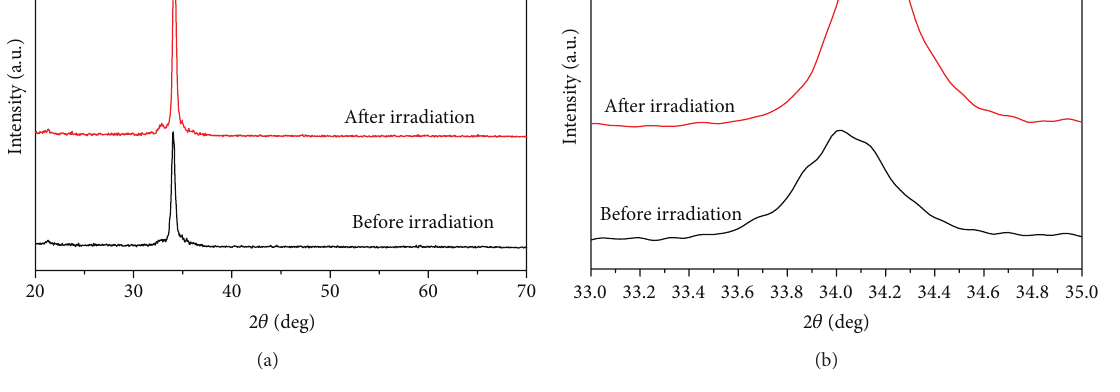
Figure 2: XRD patterns of ZnO-based thin films.